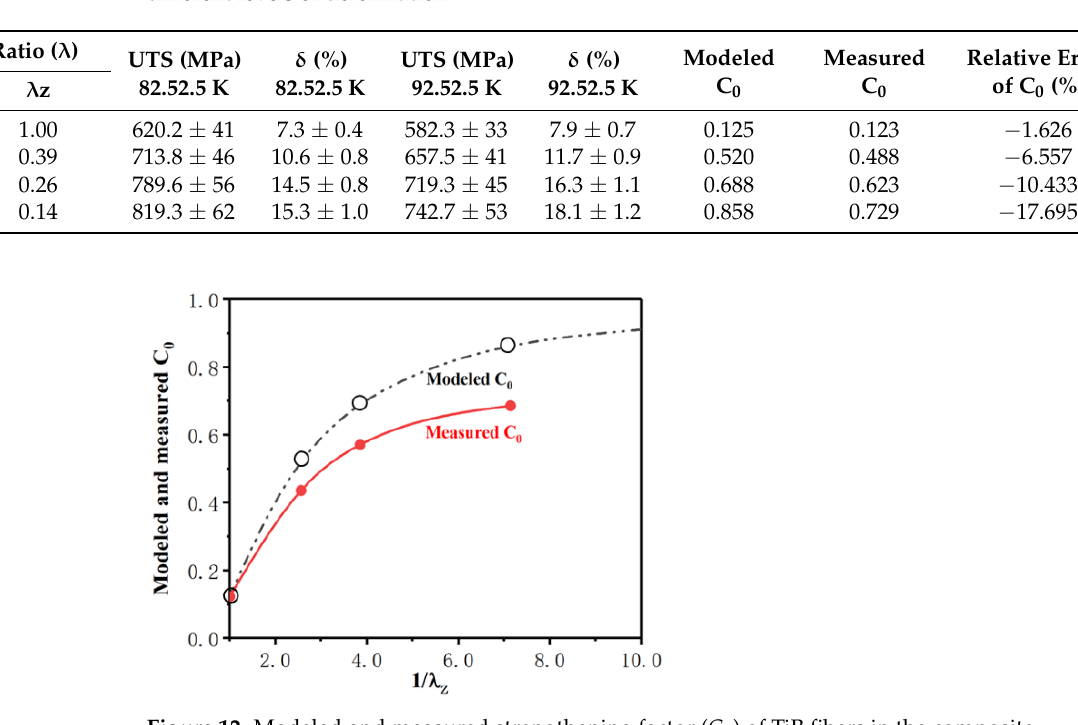
0 ) of TiB fibers in the